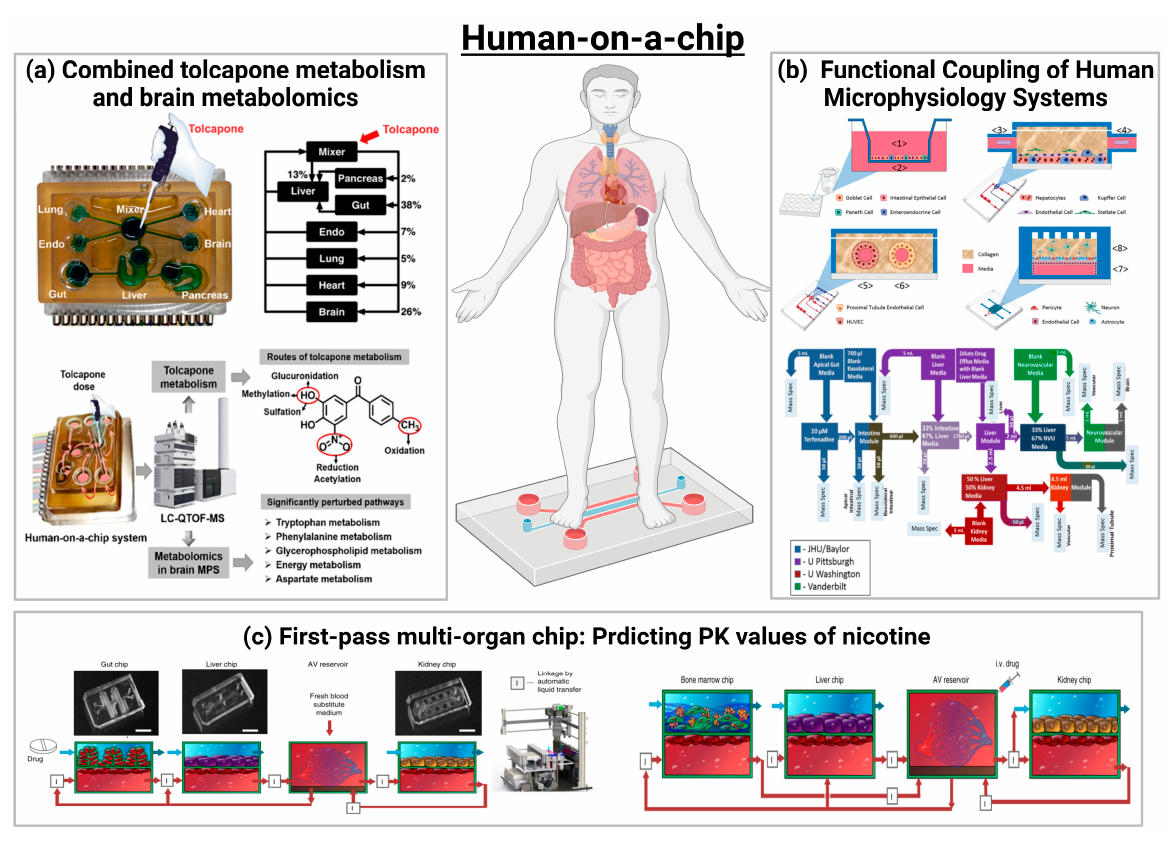
Figure 13. Schematics of human-on-chip. ( a ) Analysis of an Integrated Human Multi-organ Micro- physiological System for Combined Tolcapone Metabolism and Brain Metabolomics [114] ©Copyright 2019, Amer Chemical Soc. ( b ) Functional Coupling of Human Microphysiology Systems: Intestine, Liver, Kidney Proximal Tubule, Blood–Brain Barrier and Skeletal Muscle [55] ©Copyright 2017, Nature Research. ( c ) Quantitative prediction of human pharmacokinetic responses to drugs via fluidically coupled vascularized organ chips [113] ©Copyright 2020, Nature